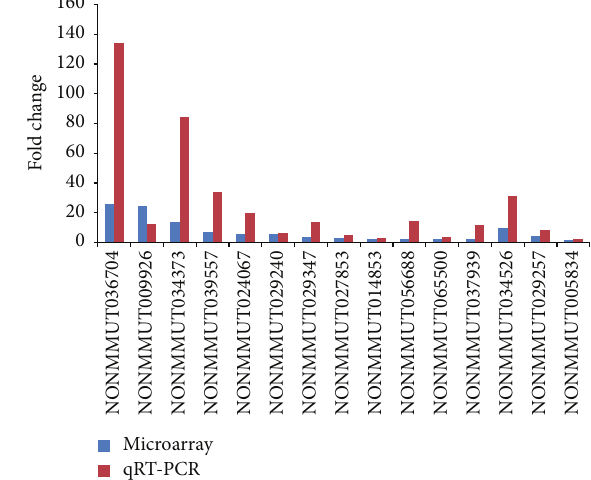
Figure 7: Comparison between microarray data and qRT-PCR resultforlncRNAs.Thevalidationresultsindicatedthatthemicroar- ray data correlated well with the qPCR